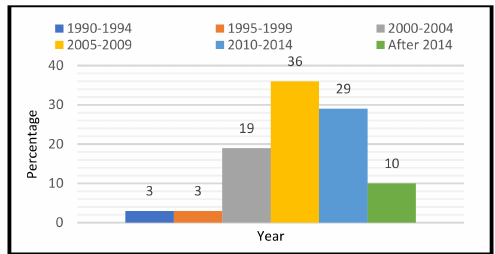
Figure 4. Length of membership of BSST.